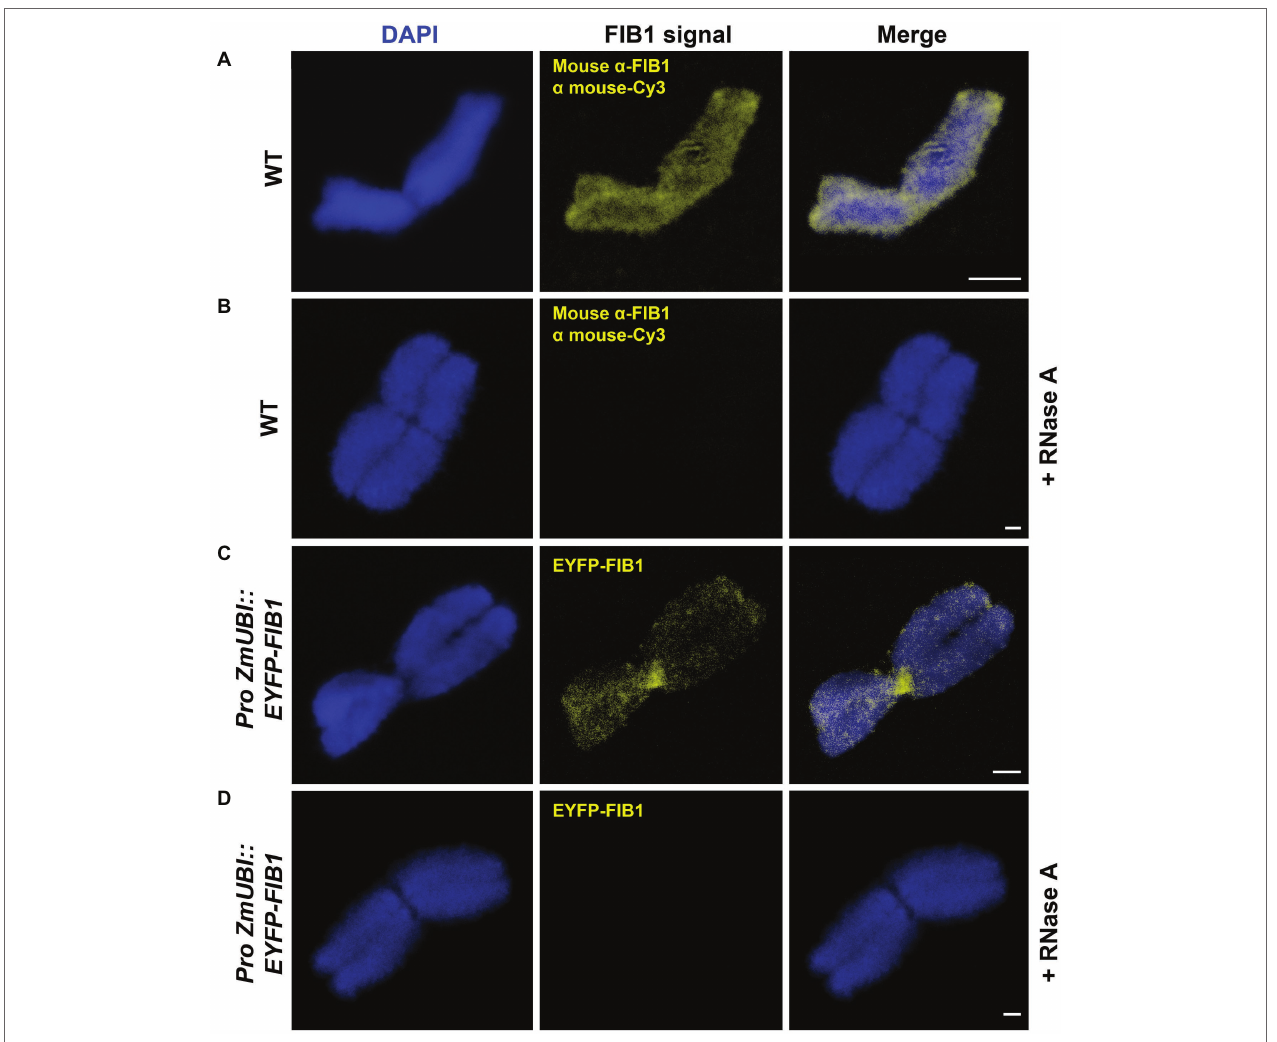
FIGURE 6 | FIB1 is removed from chromosomes by RNase A treatment. All chromosomes were counterstained with DAPI. (A) WT flow-sorted chromosome with immunolocalized FIB1. (B) Representative chromosome prepared in the same way with additional RNAse A treatment. (C) Chromosome from a transgenic reporter line expressing EYFP-FIB1 fusion protein. (D) Chromosome from the same material as in (C) with additional RNAse A treatment. Scale bars = 2 μ